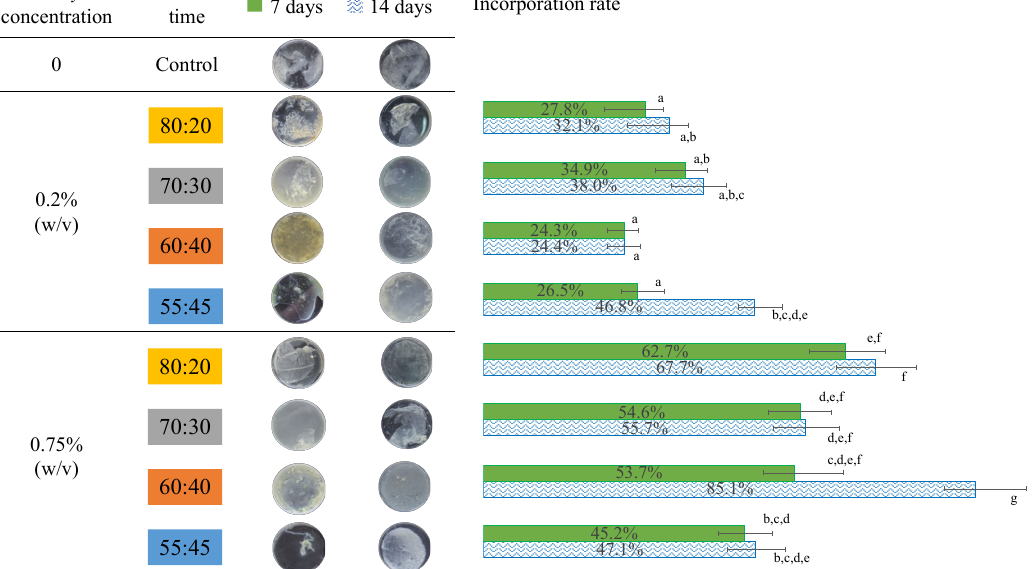
Figure 3. Symbiotic biofilms obtained to the different HS:BG-11 media ratios during 7 and 14 incubation days, and the C. debaryana incorporation rate. Values in the same column that do not share a common superscript are significantly different ( p < 0.05).